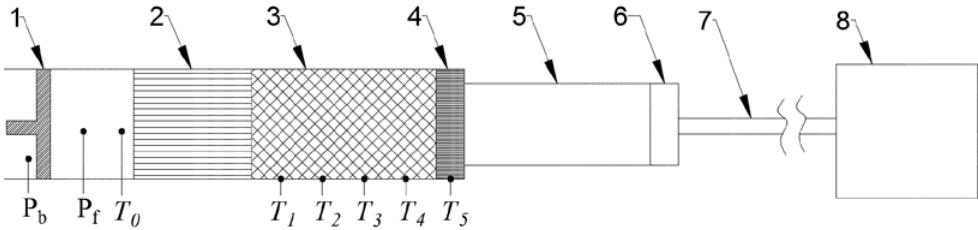
Figure 2. Schematic of the experimental apparatus. 1 Liner compressor; 2 WCHX; 3 Regenerator; 4 Clod head; 5 Pulse-tube; 6 Flow straightener; 7 Inertance tube; 8 Gas reservoir.